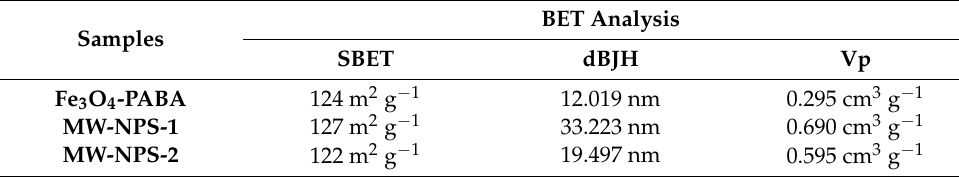
Table 2. BET analysis for Fe 3 O 4 -PABA, MW-NPS-1 and MW-NPS-2 samples. Samples